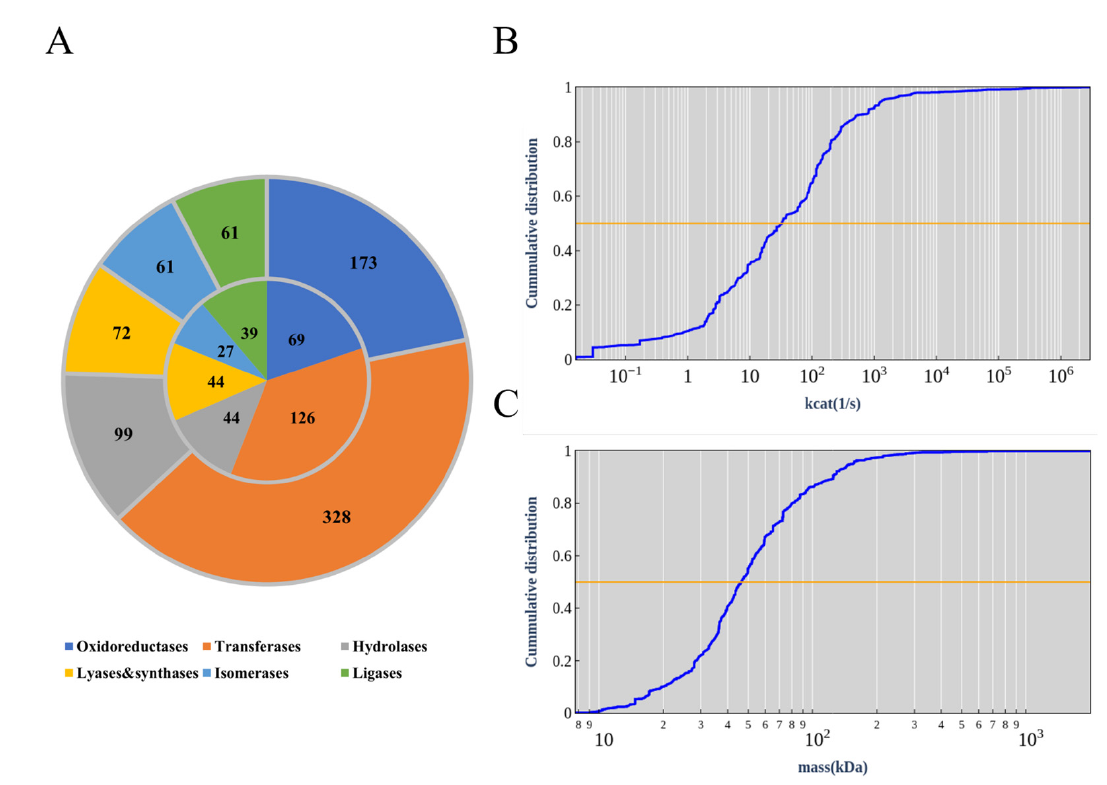
Figure 2. Basic information of ecCGL1. ( A ) Enzyme classification. The outer ring shows the 646 reactions with available enzyme kinetic data, which were divided into six categories. The inner ring shows the 304 different enzymes that catalyze these reactions according to the EC numbers, which can also be divided into six categories. ( B ) Cumulative distribution of k cat values. ( C ) Cumulative distribution of molecular weights.